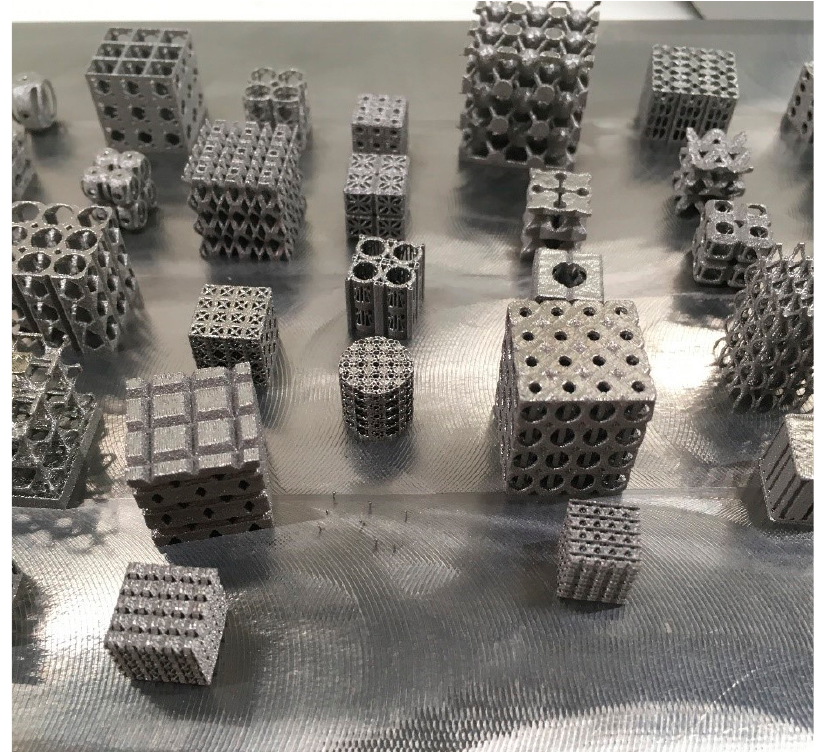
Figure 1. Innovative lattice structure showing the truss-based models.